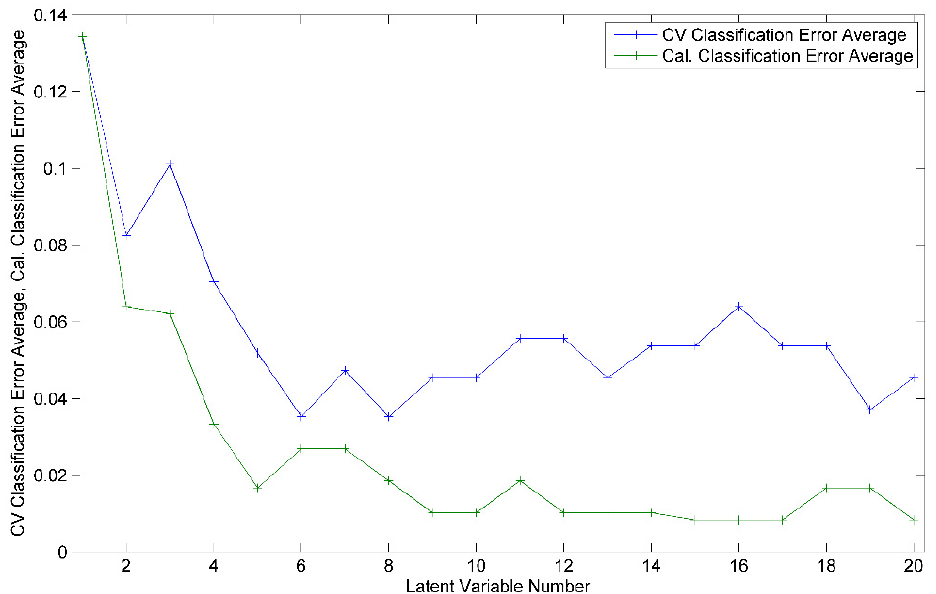
Figure 3. Cross-validation (CV) and calibration (Cal.) classification error average as function of the number of latent variables used for the construction of the PLS-DA harvesting year differentiation model.